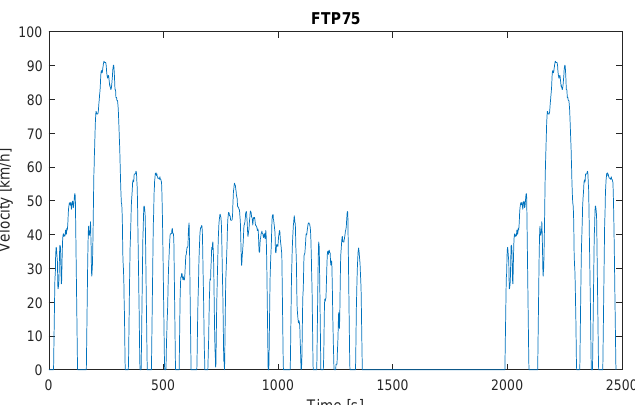
Figure 4. FTP75 driving cycle used in the